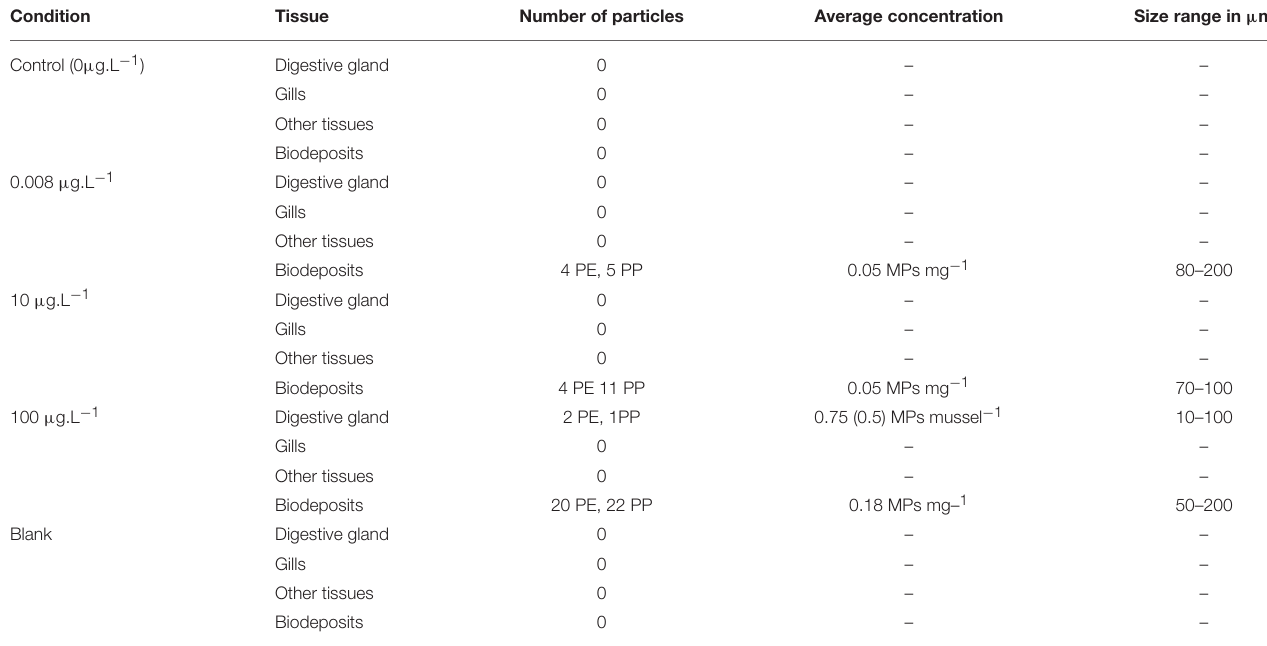
TABLE 1 | Average concentration and size range of microplastics recovered from tissue and biodeposits (feces and pseudofaeces) of Mytilus spp. after 10 days of exposure (values in parentheses represent the standard deviation).